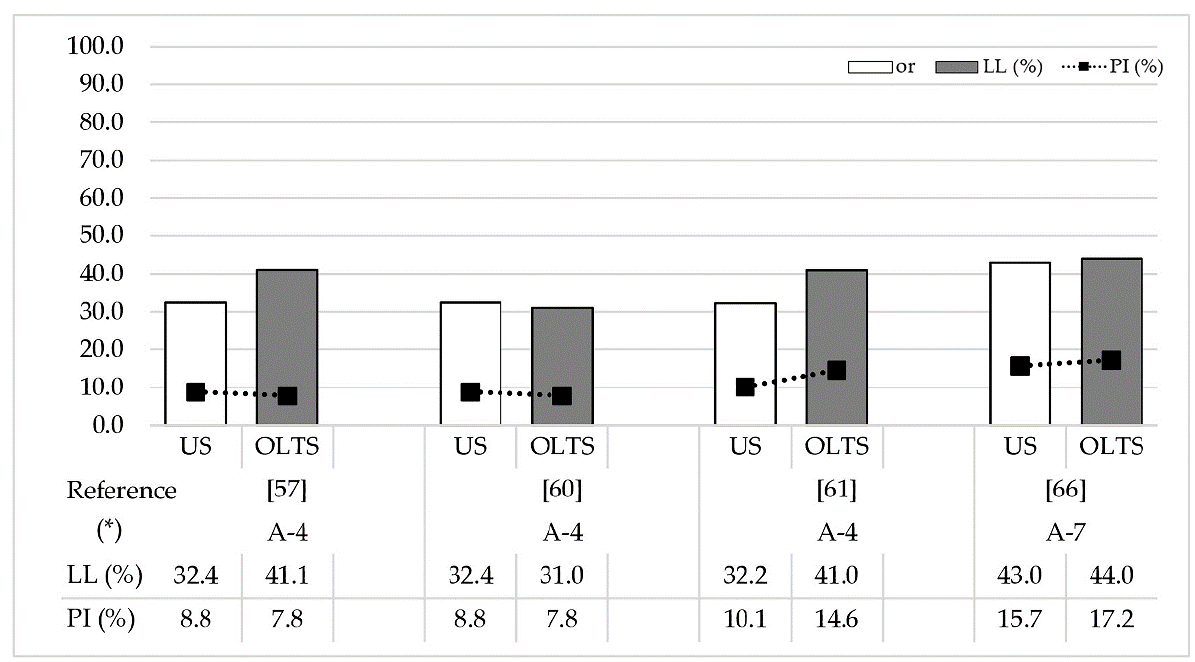
Figure 1. Comparison between Atterberg Limits. (*) AASHTO soil classification.